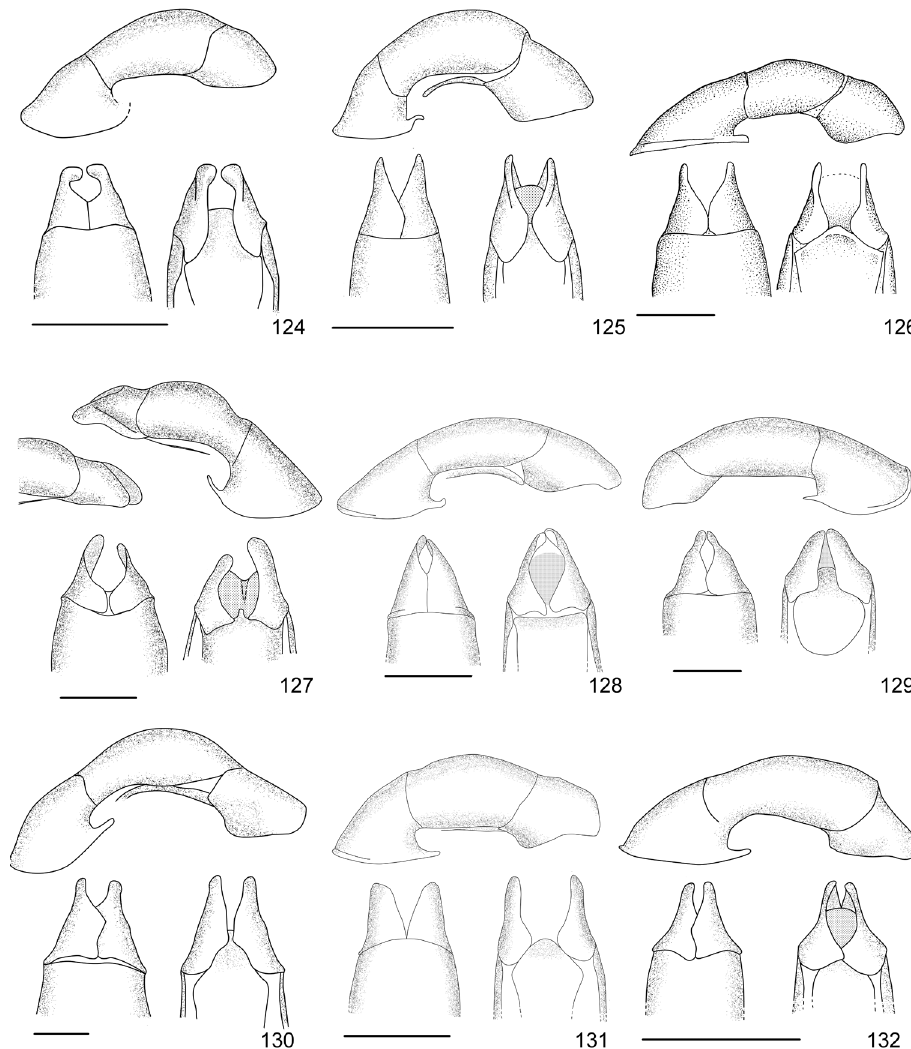
Figures 124–132. Shape of aedeagus, lateral view (top), dorsal view (bottom left), ventral view (bottom right). 124 Anomala chiriquina (Finca Cafrosa, Puntarenas, MNCR) 125 A. cinaedias (San Luis, Puntar- enas, MNCR) 126 A. clarivillosa (La Esperanza, Cartago, CEUA) 127 A. clathrata , below lateral view: detail of parameres on the other side (Cerro Bitárkara, Limón, CEUA) 128 A. coffea (Estación Pitilla, Guanacaste, MNCR) 129 A. cupreovariolosa (Las Cruces, Puntarenas, MNCR) 130 A. cupricollis (Finca San Gabriel, Alajuela, MNCR) 131 A. cyclops (Cerro El Hacha, Guanacaste, MNCR) 132 A. discoidalis (Estación Cuatro Esquinas, Limón, MNCR). Scale bars: 1 mm. Figs 127, 129 modified from Filippini et al. (2014); Figs 128, 131 from Filippini et al. (2015c); Fig. 126 from Filippini et al.